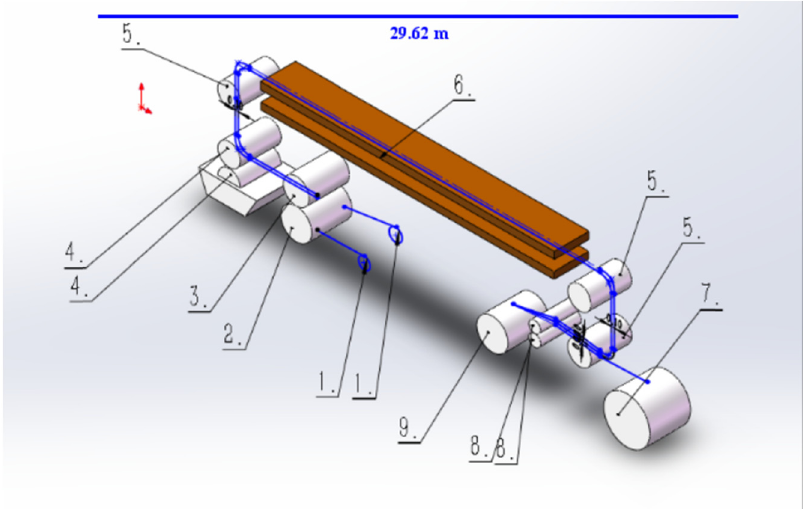
Figure 4: Modi fi ed food packaging machine for application of metal copper foil strips and protection laminate. Blue line indicates the feed path of the fi lm: ( 1 ) current - carrying, ( 2 ) PVA - CF fi lm roller, ( 3 ) top laminate, ( 4 ) glue applicator roller box, ( 5 ) guide roller, ( 6 ) forced convection oven, ( 7 ) button laminate, ( 8 ) hot drum, and ( 9 ) winding